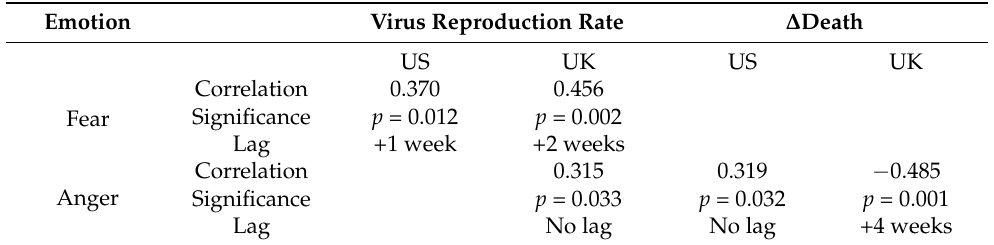
Table 4. Correlation between the pandemic development and emotions. Emotion Virus Reproduction Rate ∆ Death